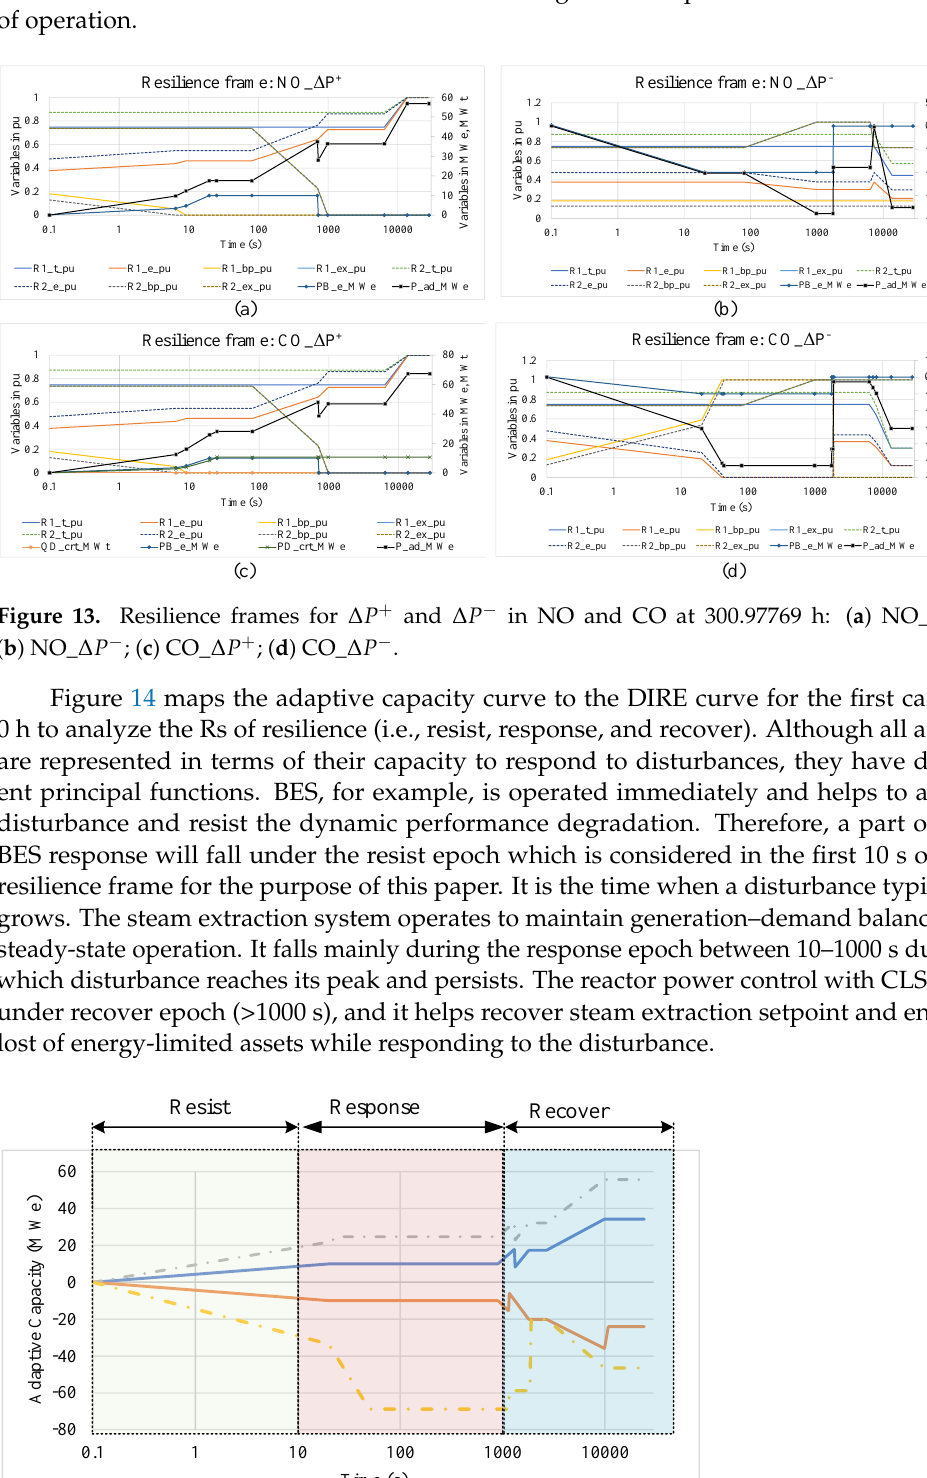
an idea of the disturbance characteristics the microgrid can respond to in different modes of operation.